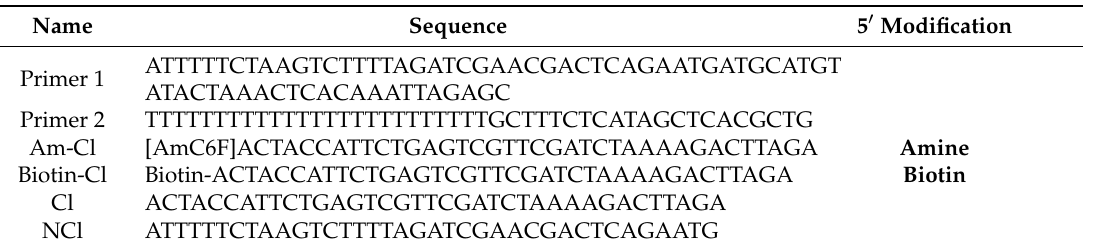
Table 1. Oligonucleotides used in the present